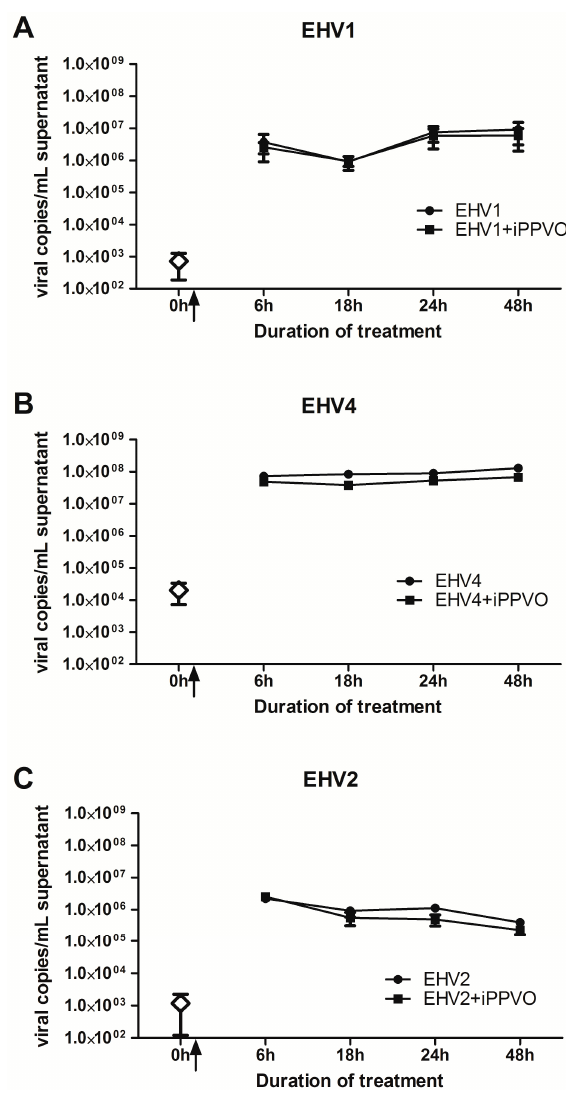
Figure 5. EHV titre in supernatant at different time points after ( A ) EHV-1 infection with or without iPPVO; ( B ) EHV-4 infection with or without iPPVO; (C) EHV-2 infection with or without iPPVO. The arrows represent the time of infection. White lozenges represent the virus genome copies detected in PBMC before infection. Data are reported as mean ± SEM viral copies/mL of supernatant.